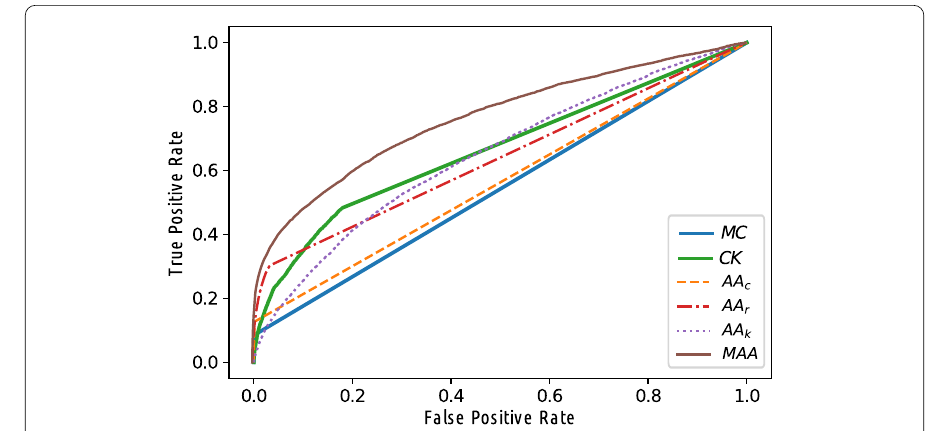
Figure 3 ROCcurvescorrespondingtodyadicmetrics,AAsingle-layeredscores,andthe MAA metric. In solid lines, MC , CK and MAA scores. The MAA metric obtained with coefficients η ck = 0.05 and η cr = 0.1 shows the best performance of the whole set of metrics. The single-layer versions of the AA metric are shown in dashed (collaboration layer), dot-dashed (citation layer) and dotted (keywords layer) lines. The normalized metrics ( NMC and NCK ) completely overlap their non-normalized counterparts, and thus are removed for clarity. Similarly, the AA metric applied over the aggregated network (not shown) completely overlaps with the AA k curve, showing that the main contribution in the aggregated network comes from the keywords